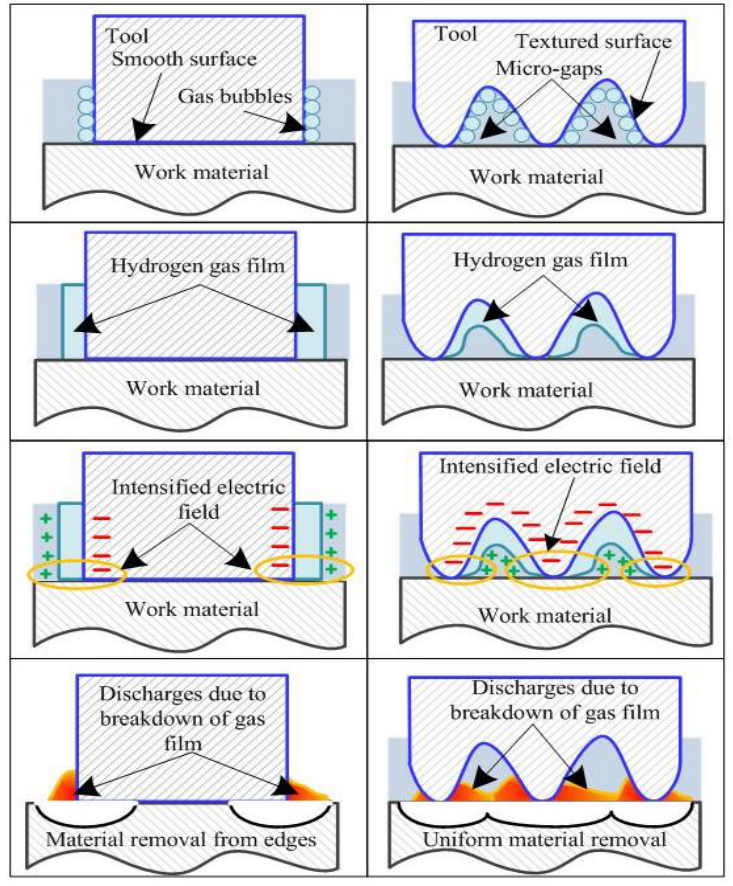
Figure 10. Mechanism of material removal with smooth and rough tool electrodes during ECSM process.